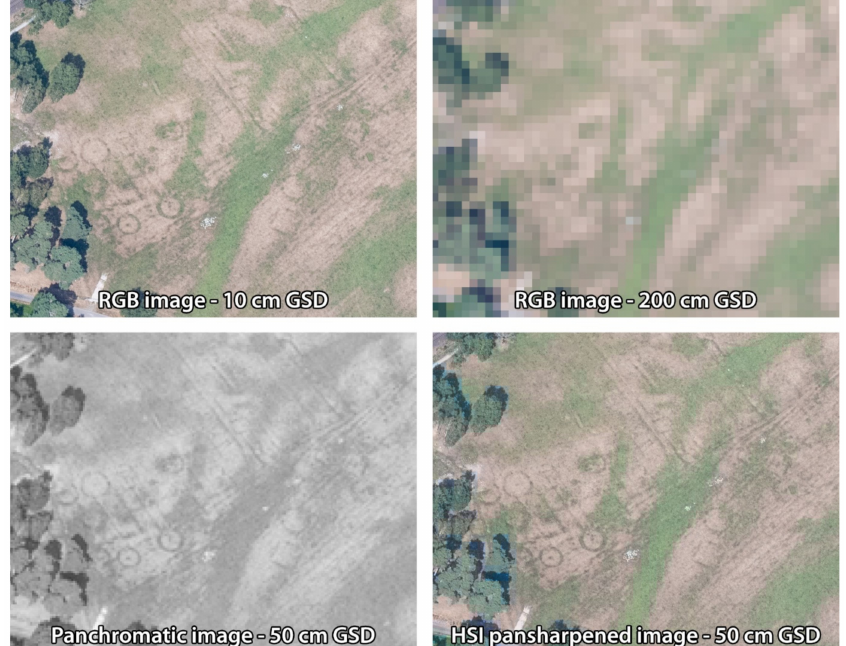
identification of archaeological features. Graphic: Geert Verhoeven; Source image DP281499 ©